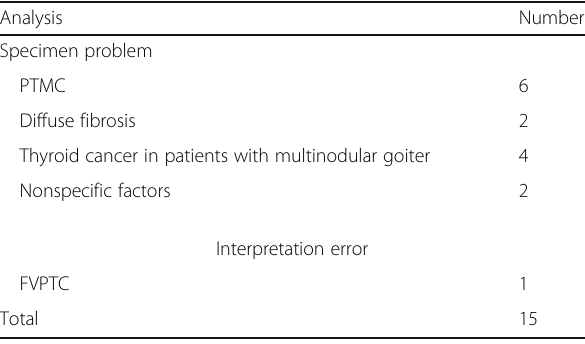
Table 3 The analysis for the false-negative cases Analysis